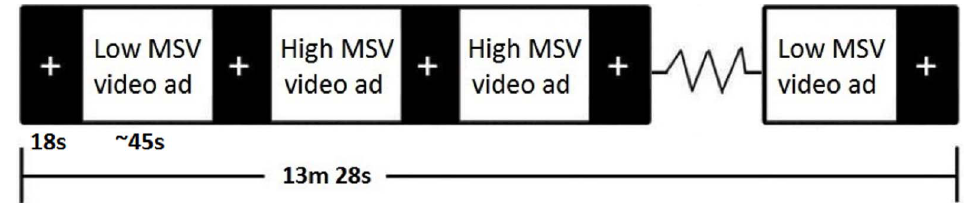
Figure 1. Design of the video message task. The actual task displays 16 video messages (8 high MSV and 8 low MSV) in pseudorandom order (the order presented above is one possible